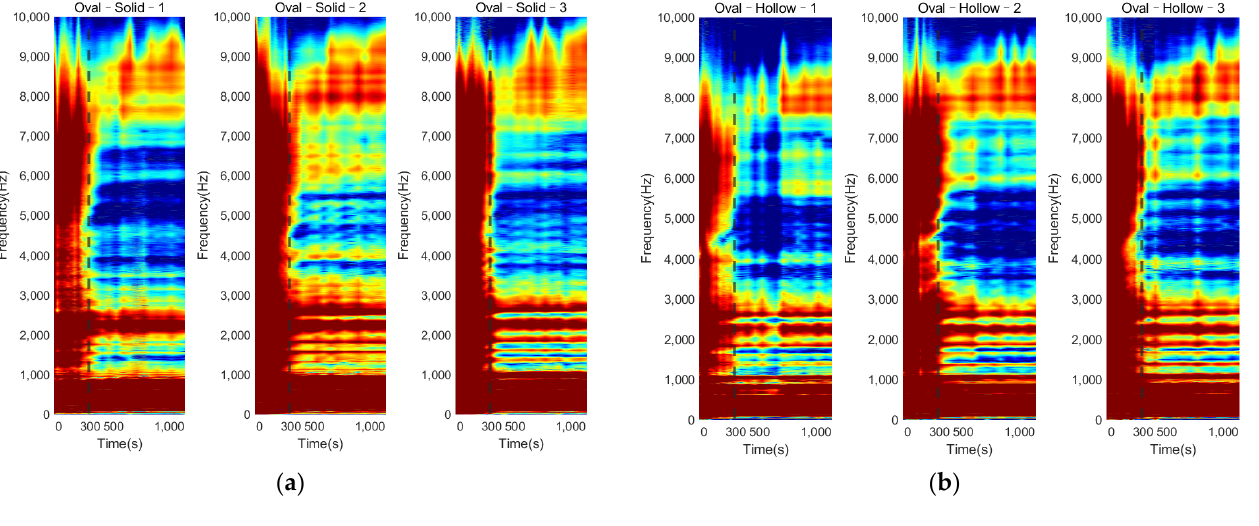
Figure 14. Plots of the normalized magnitude development as the function of cure time for oval implants with ( a ) solid IM stem and ( b ) hollow IM stem.